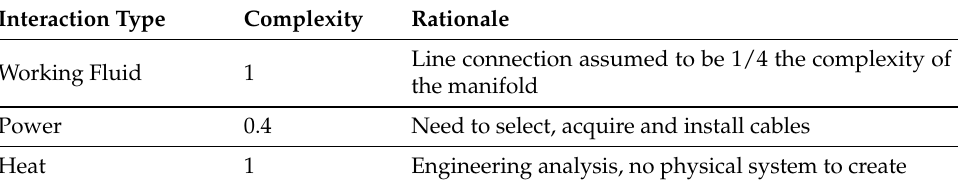
Table 6. Interaction complexity values β ij and γ im and rationales.